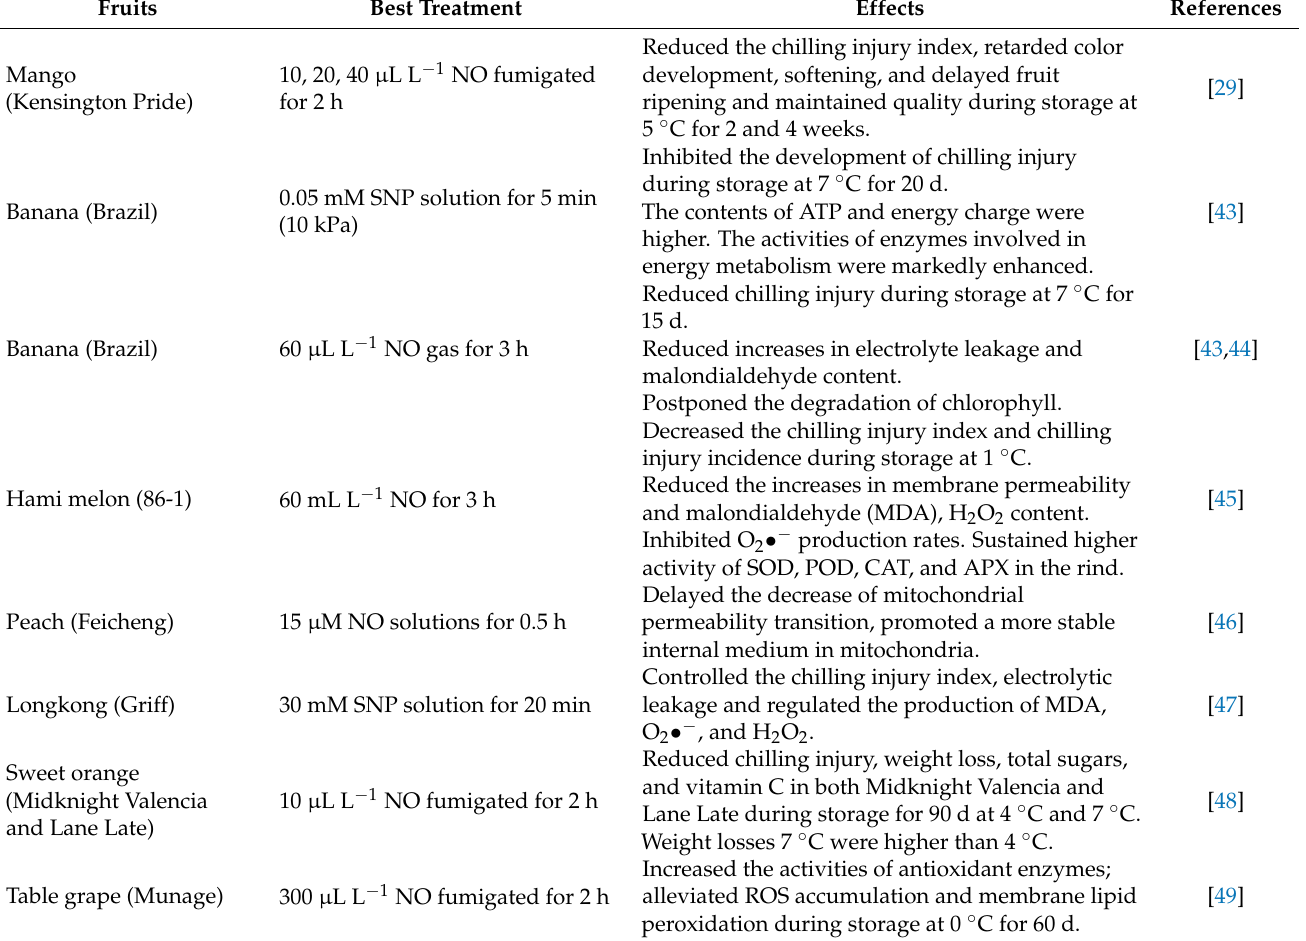
Table 2. The effect of NO treatment on alleviating chilling injury.